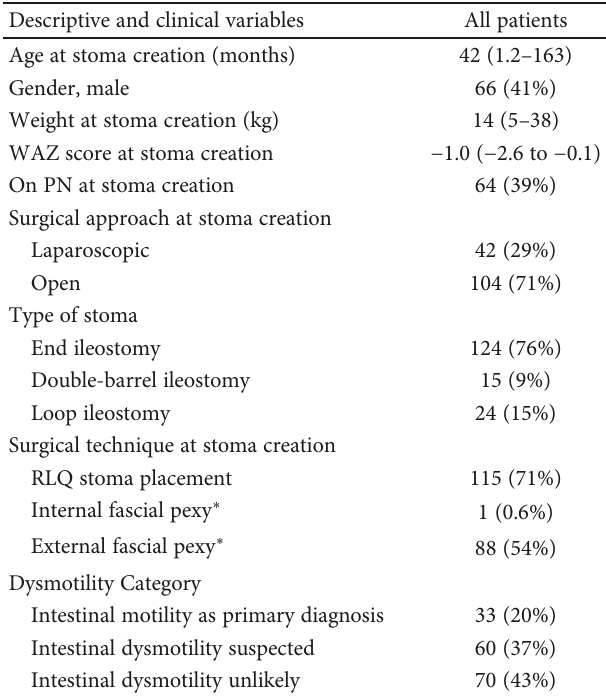
Table 1: Population